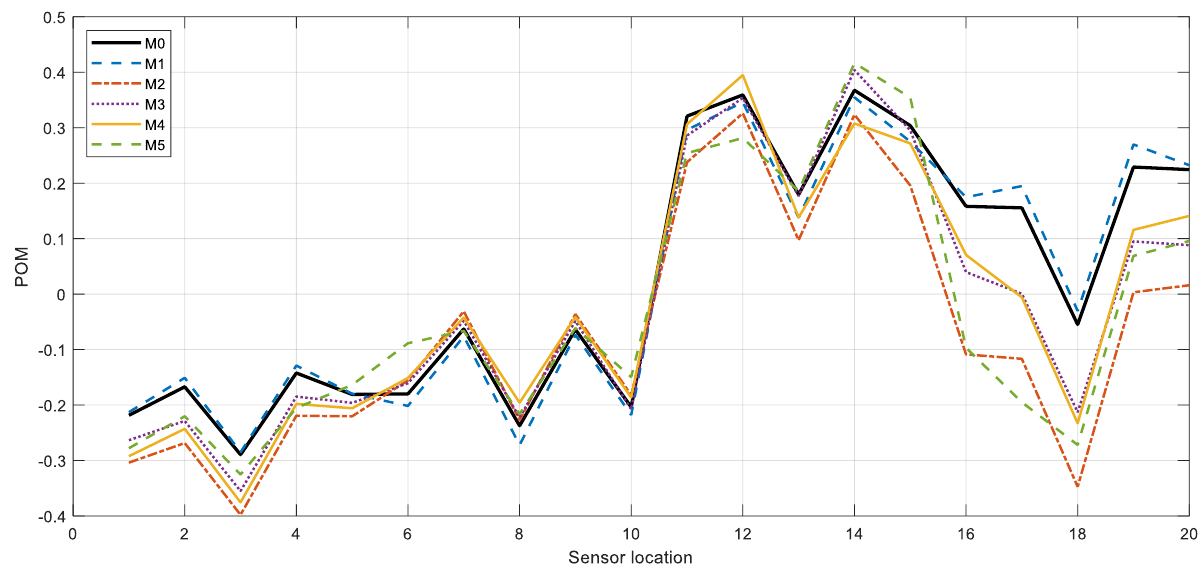
Figure 2. Healthy average first POMs for each